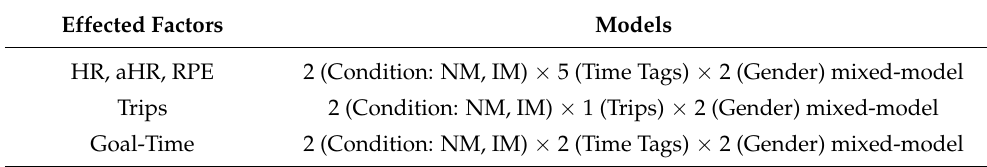
Table 3. Affected factors and statistical